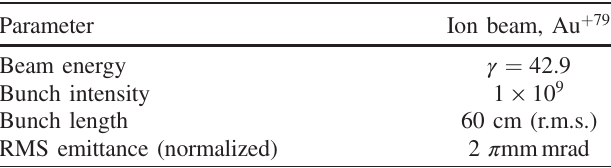
TABLE I. Parameters of ion beam. Parameter